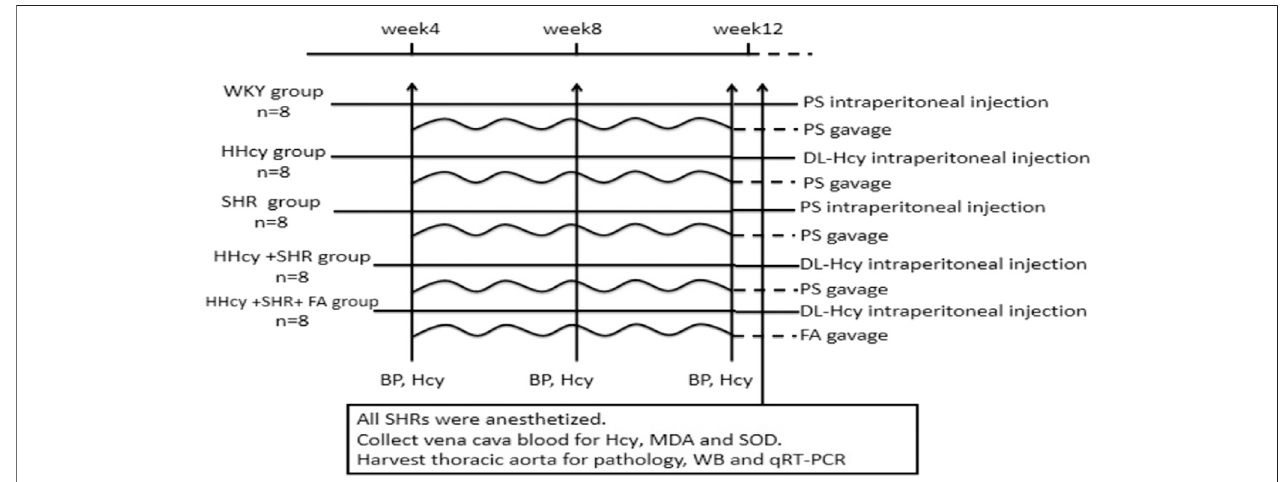
FIGURE1| Diagramofthestudydesign.Thehorizontallinesrepresenttheintraperitonealinjectionofdifferentdrug.Thewavylinesrepresentthegavageofdifferent drug. The arrows refer to the intervention points of different experimental operations. WKY, Wistar-Kyoto; HHcy, hyperhomocysteinemia; SHR, spontaneously hypertensive rat; FA, folate; PS, physiological saline; Hcy, homocysteine; MDA, malondialdehyde; SOD, superoxide dismutase; WB, western blotting; qRT-PCR, quantitative real-time polymerase chain reaction.